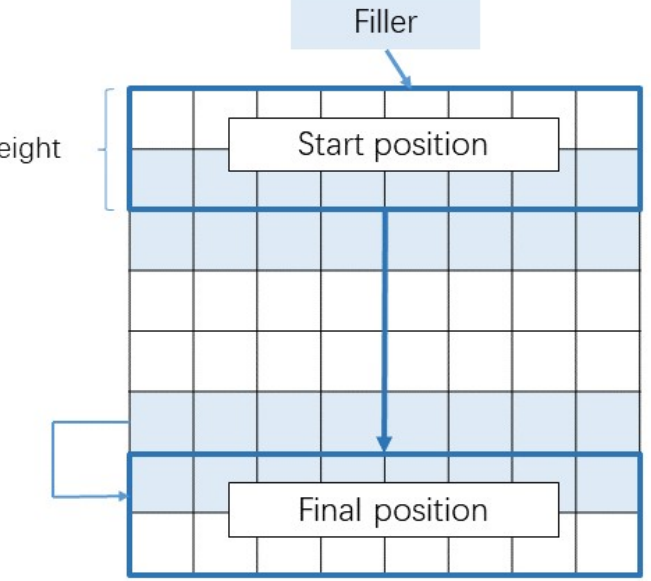
Figure 4. The sliding direction of the filter in 1D-CNN.